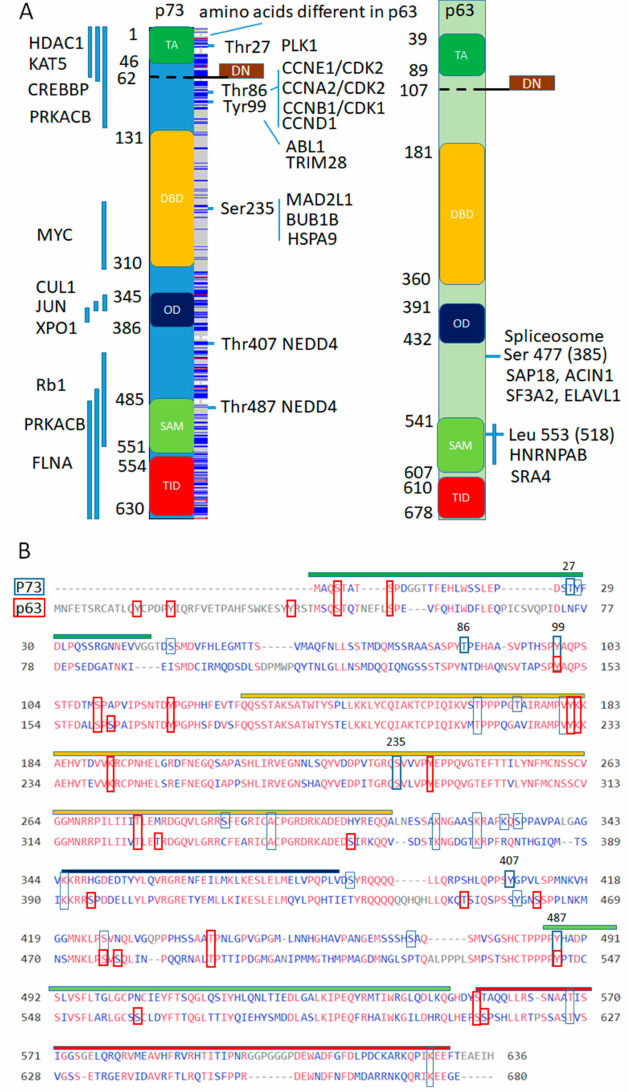
Figure 4. Conservation of interaction sites and domains between p63 and p73 for putative protein complexes interacting with p73 and not with p63. ( A ). Domain structure of p73 and p63, with highlighted domains along with mapped interacting regions on the left shown as vertical blue lines and specific amino acids on the right with corresponding interacting proteins. Blue lines in the box along the p73 domain structure represent amino acids that are different in the p63. DN- domain is a result of the alternative splicing that replaces TA- domain at the N-terminus. ( B ). Alignment of p73 (O15350) and p63 (Q9H3D4) sequences with perfectly aligned shown in red. In blue quadrants—p73 post-translational modifications and in red—p63 post-translational modifications (PTM) from the dbPTM (http://dbptm.mbc.nctu.edu.tw) with numbers marking amino acids that participate in distinct p73 protein interactions. Conserved PTM sites in between p63 and p73 are marked by elongated